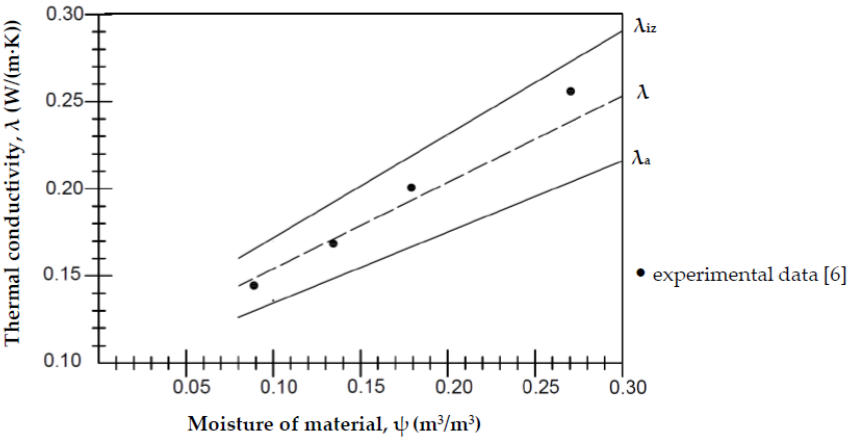
Figure 7. Calculated dependencies of thermal conductivity λ a , λ iz and λ = ( λ a + λ iz ) / 2 on material moisture ψ determined for aerated concrete with apparent density ρ = 485kg/m 3 and experimental data from work [6].